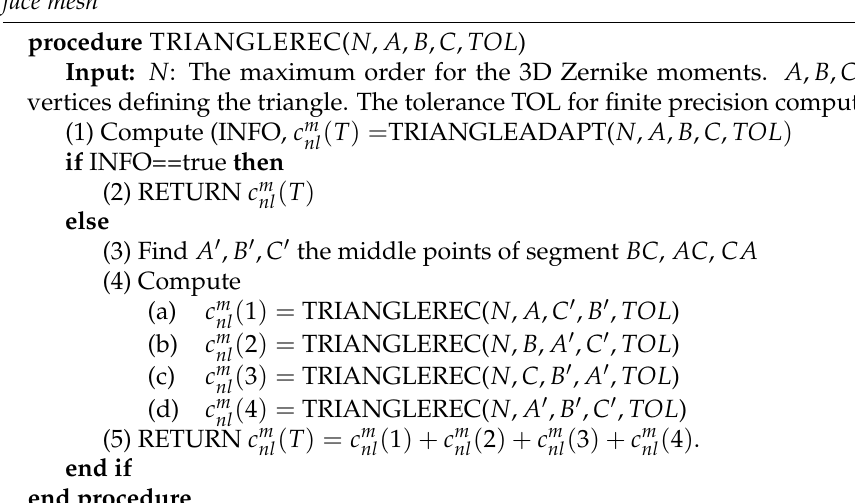
Figure 4. The strength N of the quadrature rule needed to compute the Zernike moment associated with a triangle of the surface mesh representing a shape is plotted against the surface area of this triangle. Algorithm 5 Recursive computation of Zernike moments associated with one triangle of a sur- face